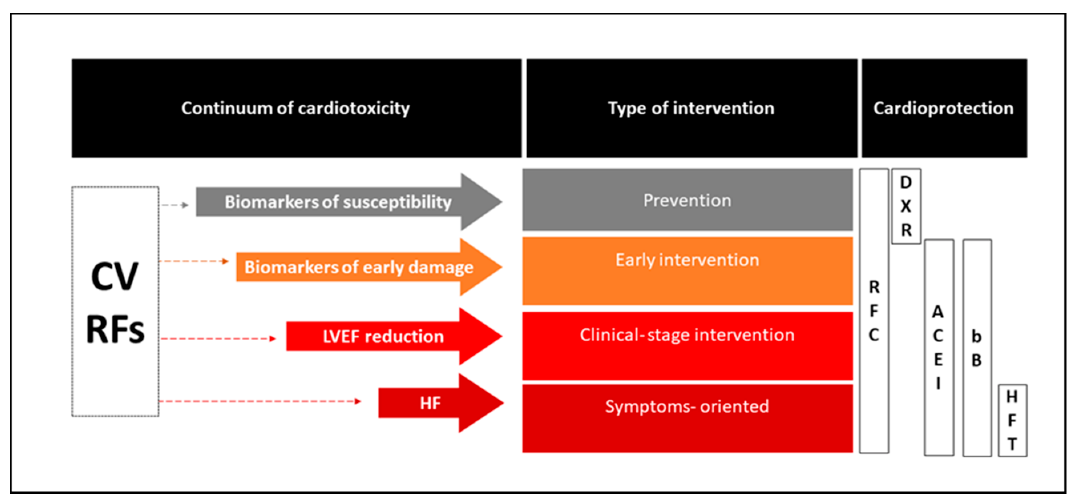
Figure 2. Overview of the current clinical use of cardiac protective agents across the continuum of cardiotoxicity. ACE-Is: angiotensin-converting enzyme inhibitors, bBs: beta blockers, CV: cardiovascular, DXR: dexrazoxane, HF: heart failure, HFT: heart-failure-specific therapy, LVEF: left ventricular ejection fraction, RFC: risk factors control, RFs: risk factors.